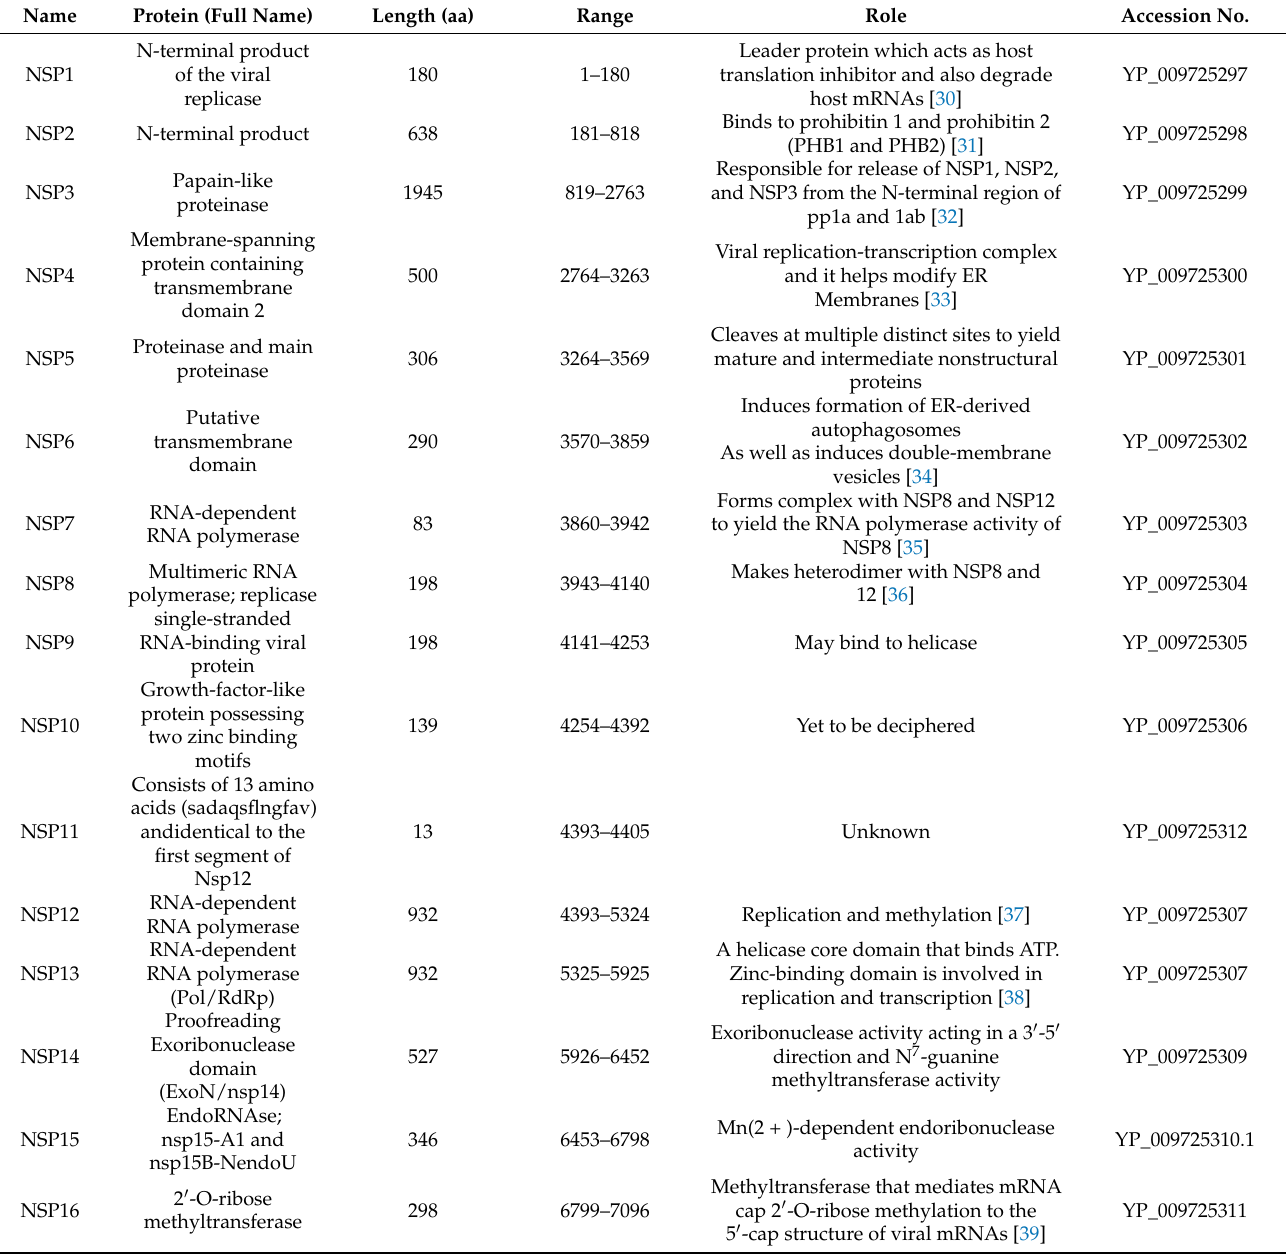
Table 1. Brief description of various non-structural proteins of